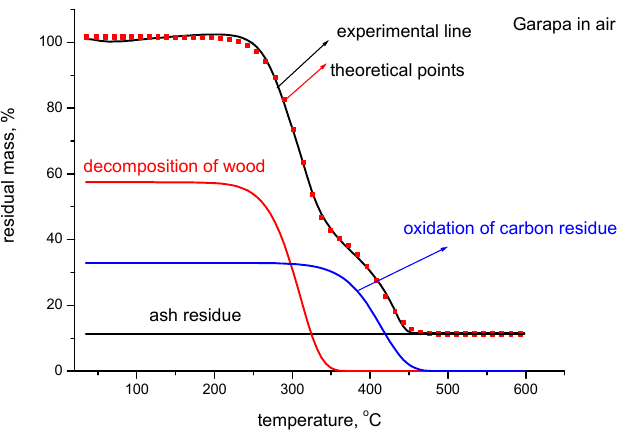
Figure 3. The deconvolution of non-isothermal thermogravimetry–temperature run into corre- sponding component processes with the use of Equation (1) for Garapa wood in air at the rate of heating of 10 °C/min. Points represent the theoretical run.